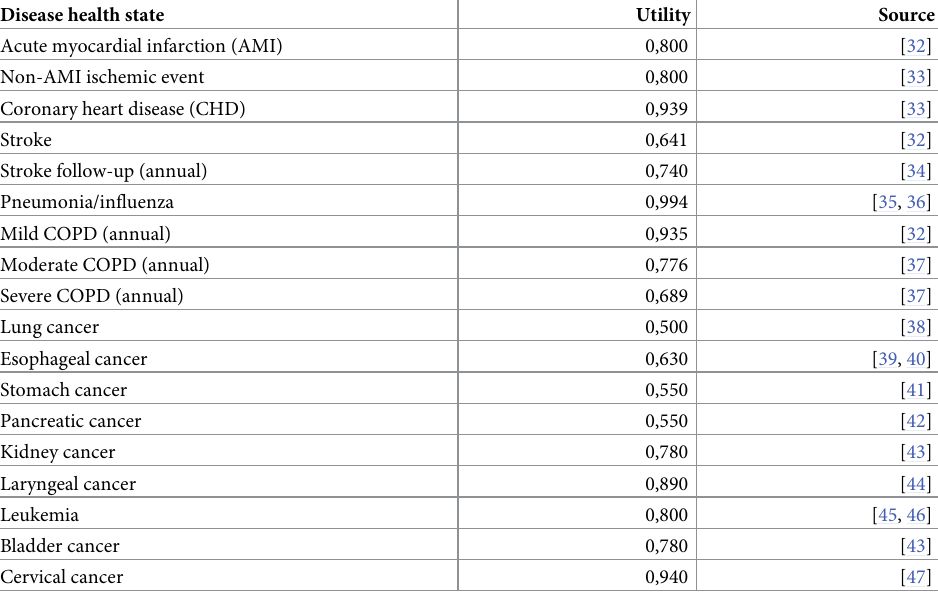
Table 4. Utilities values used in the